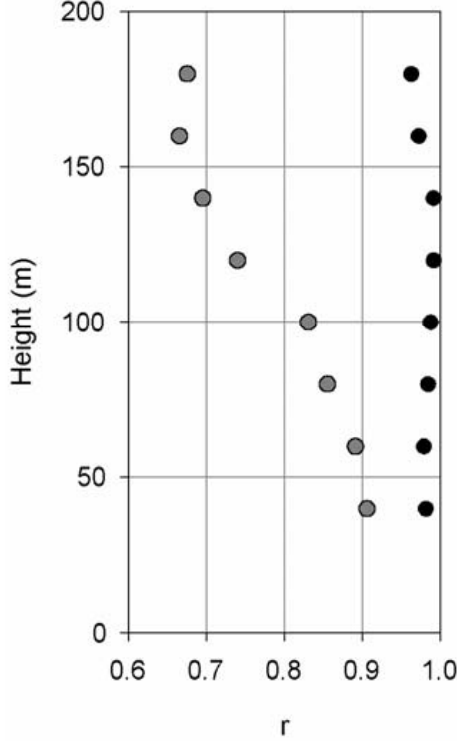
Fig. 9. Pearson correlation coefficients calculated between exper- imental and modelled modules (in grey) and arguments of ¯ V h (in (cid:12) (cid:12) ¯ V (cid:12) (cid:12) in the lowest h Fig. 9 . Pearson correlation coefficients calculated between experimental and modelled V in the lowest level fitted by a h modules (in grey) and arguments of